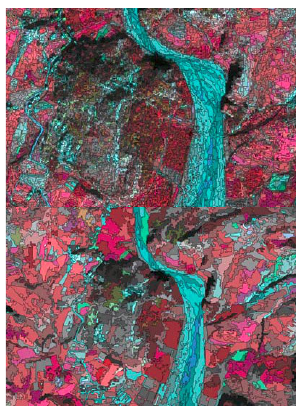
Figure 11 and Figure 12.. Ikonos image: first level (fine) of segmentation; Ikonos image: second level (medium) of